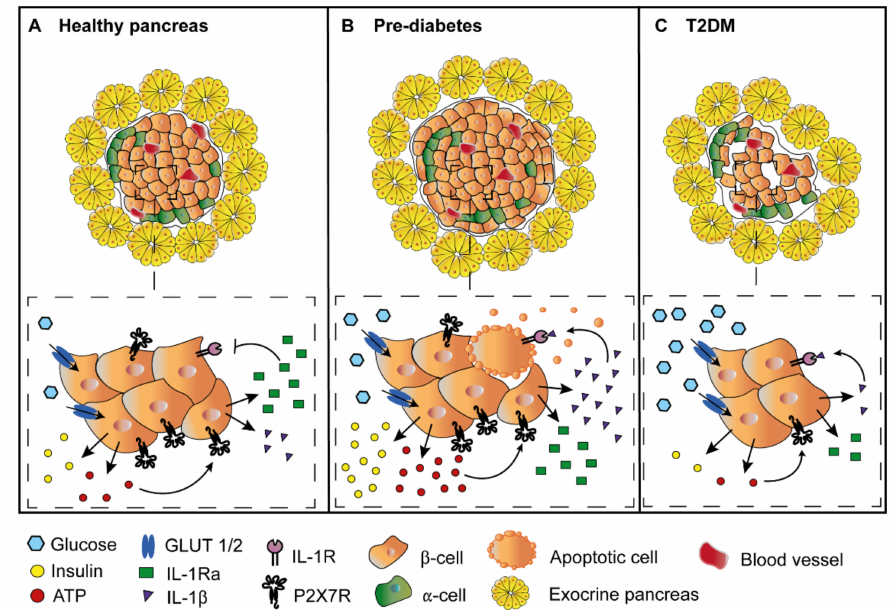
Figure 2. Role of the P2X7R in the healthy pancreas, in pre-diabetic conditions and overt T2DM. ( A ) In healthy subjects, low grade P2X7R stimulation contributes to β -cell homeostasis by keeping a careful balance of IL-1 β and IL-1Ra release, and at the same time providing a trophic stimulus that supports β -cell proliferation. ( B ) In pre-diabetic conditions, hyperglycemia triggers insulin and ATP release, which stimulates the P2X7R, that in turn promotes enhanced release of both IL-1 β and IL-1Ra. IL-1Ra release prevents, at least in part, the deleterious effects of IL-1 β on β -cells. However, continued β -cell stimulation by sustained hyperglycemia, on one hand leads to a progressive exhaustion of insulin secretion, and on the other hand, causes a large increase in the intra-islet eATP concentration, causing an unchecked release of IL-1 β . In this context, IL-1Ra cannot anymore protect β -cells from IL-1 β effects. The combined action of IL-1 β and eATP then promotes β -cell apoptosis and the shrinkage of Langerhans islet mass. ( C ) In overt T2DM, β -cell number is reduced, insulin secretion is impaired, and P2X7R expression by β -cells is